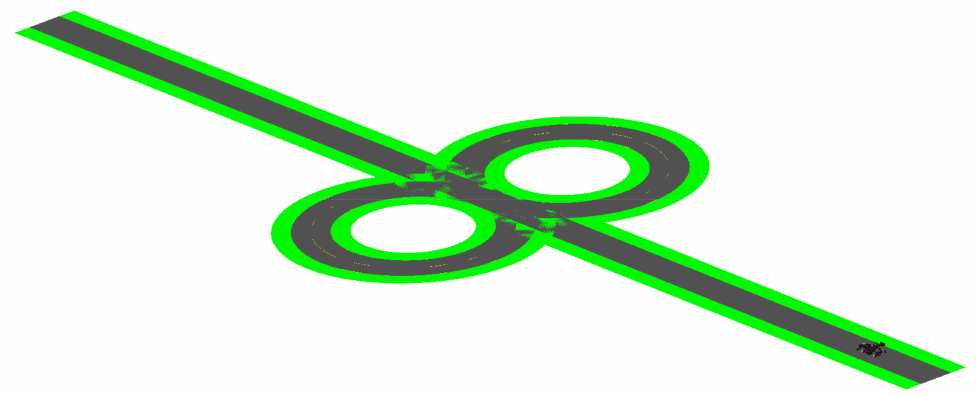
Figure 16. Skidpad